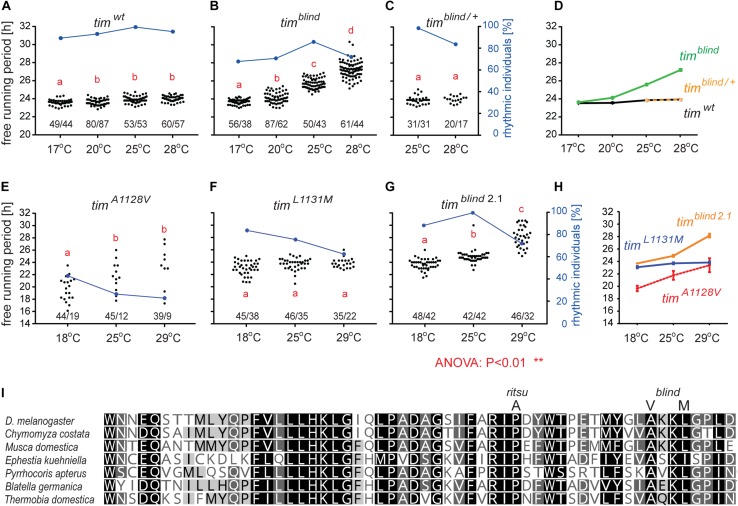
timelessblind is a circadian clock mutant with defect in temperature compensation [each dot in panels A–C and E–G represents the free running period (tau, τ) of individual male flies recorded during 10 days in DD at the specified temperature]. Blue dots connected with a line indicate the percentage of rhythmic individuals (scale is on the right y-axis) at a particular temperature). (A)
τ of control Canton S wild-type (wt) flies, (B)
timblind homozygous, and (C)
timblind/+ heterozygous D. melanogaster males in constant darkness (DD) and constant temperature (17, 20, 25, and 28°C). (D) Comparison of τ (shown as mean ± SEM) for all three genotypes indicates the temperature-dependent τ lengthening in timblind and confirms that the mutant is fully recessive. (E)
timA1128V, a mutant with only the first timblind position mutated, is mostly arrhythmic with a potential temperature compensation defect in rhythmic individuals, (F)
timL1131M, a mutant with only the second timblind position mutated, exhibits normal and fully temperature-compensated τ. (G) The synthetic timblind2.1 allele shows temperature compensation defects and solid rhythmicity. (H) Comparison of τ (shown as mean ± SEM) for re-engineered single and double-mutant versions of timblind. (I) Alignment of various insect TIM proteins near TIMrit and TIMblind mutations (specific substitution in rit and blind is shown above the alignment). Insects are ordered according to their phylogenetic relationship from the most diverged at the top to the most ancestral at the bottom, with the following insect groups: Diptera (Drosophila, Chymomyza and Musca), Lepidoptera (Ephestia), Heteroptera (Pyrrhocoris), Blattodea (Blatella), and Ametabola (Thermobia). A, V, and M refer to the single letter aminoacid code.